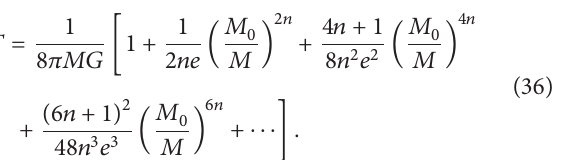
units related to this work and their values in the SI units: = 1.61620 × 10 −35 m, 𝑀 = 2.17651 × 10 −8 kg, 𝑇 = ℓ Pl Pl Pl 1.41683 × 10 32 K, and 𝑡 = 5.39106 × 10 −44 s, the Planck unit Pl of entropy: 𝑆 Pl = 1.38065 × 10 −23 J/K, the Planck unit of heat capacity: 𝐶 Pl = 1.38065 × 10 −23 J/K, and the Planck unit of power of radiation: 𝑃 Pl = 3.62831 × 10 53 J/s) in all figures